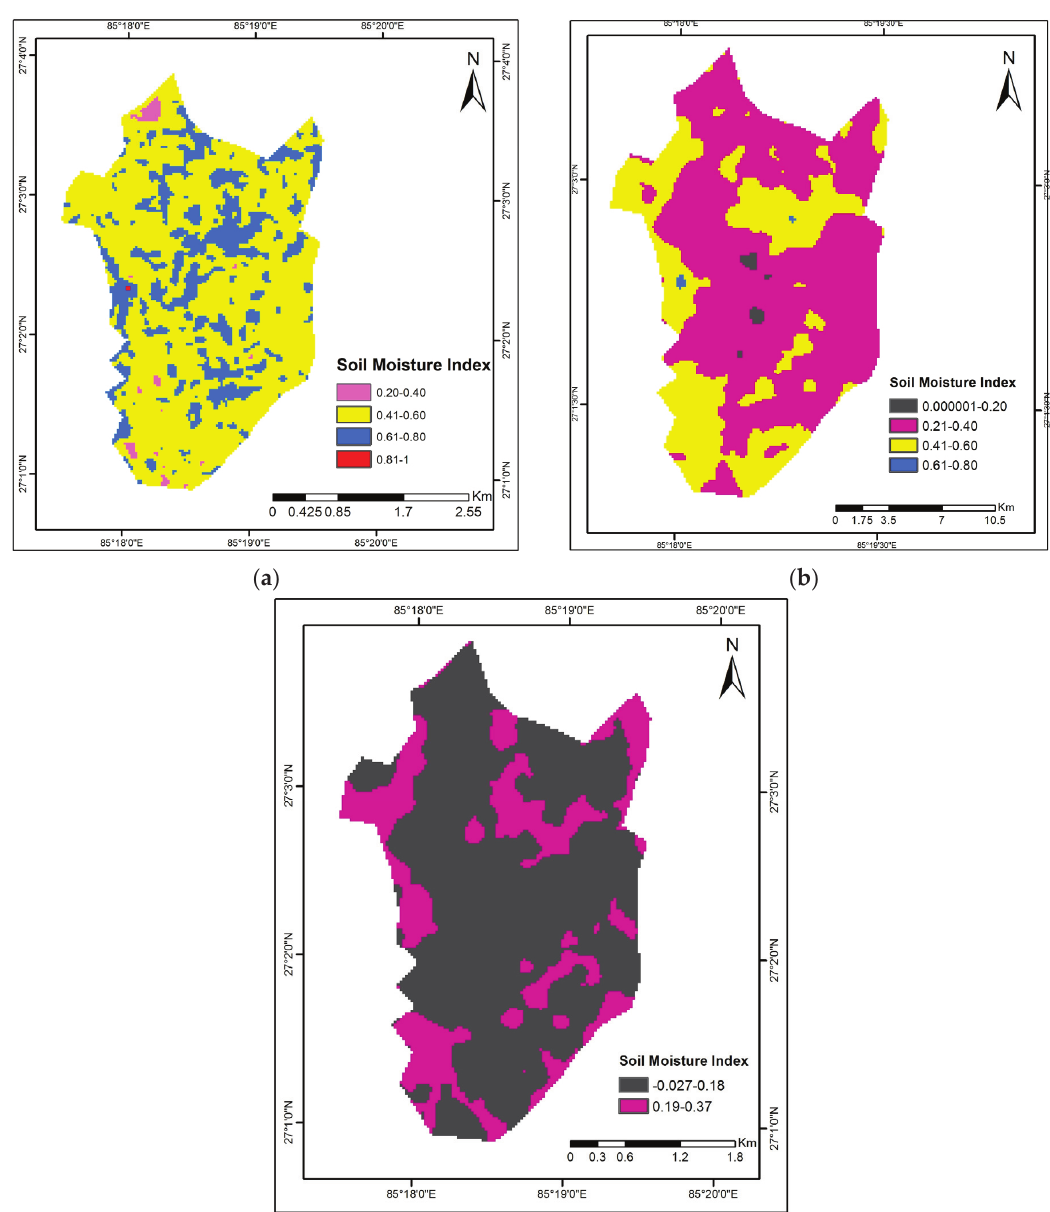
Figure 8. Soil moisture index of Simara Bhawanipur VDC for different years: ( a ) 2000; ( b ) 2014; and ( c ) 2015.